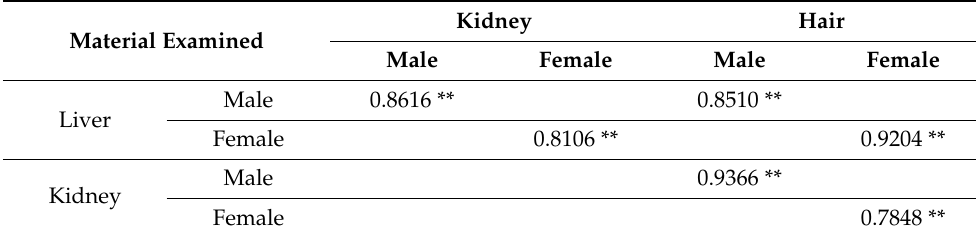
Table 4. Correlations between the contents of mercury in tissues of individuals representing both sexes at p ≤ 0.01.